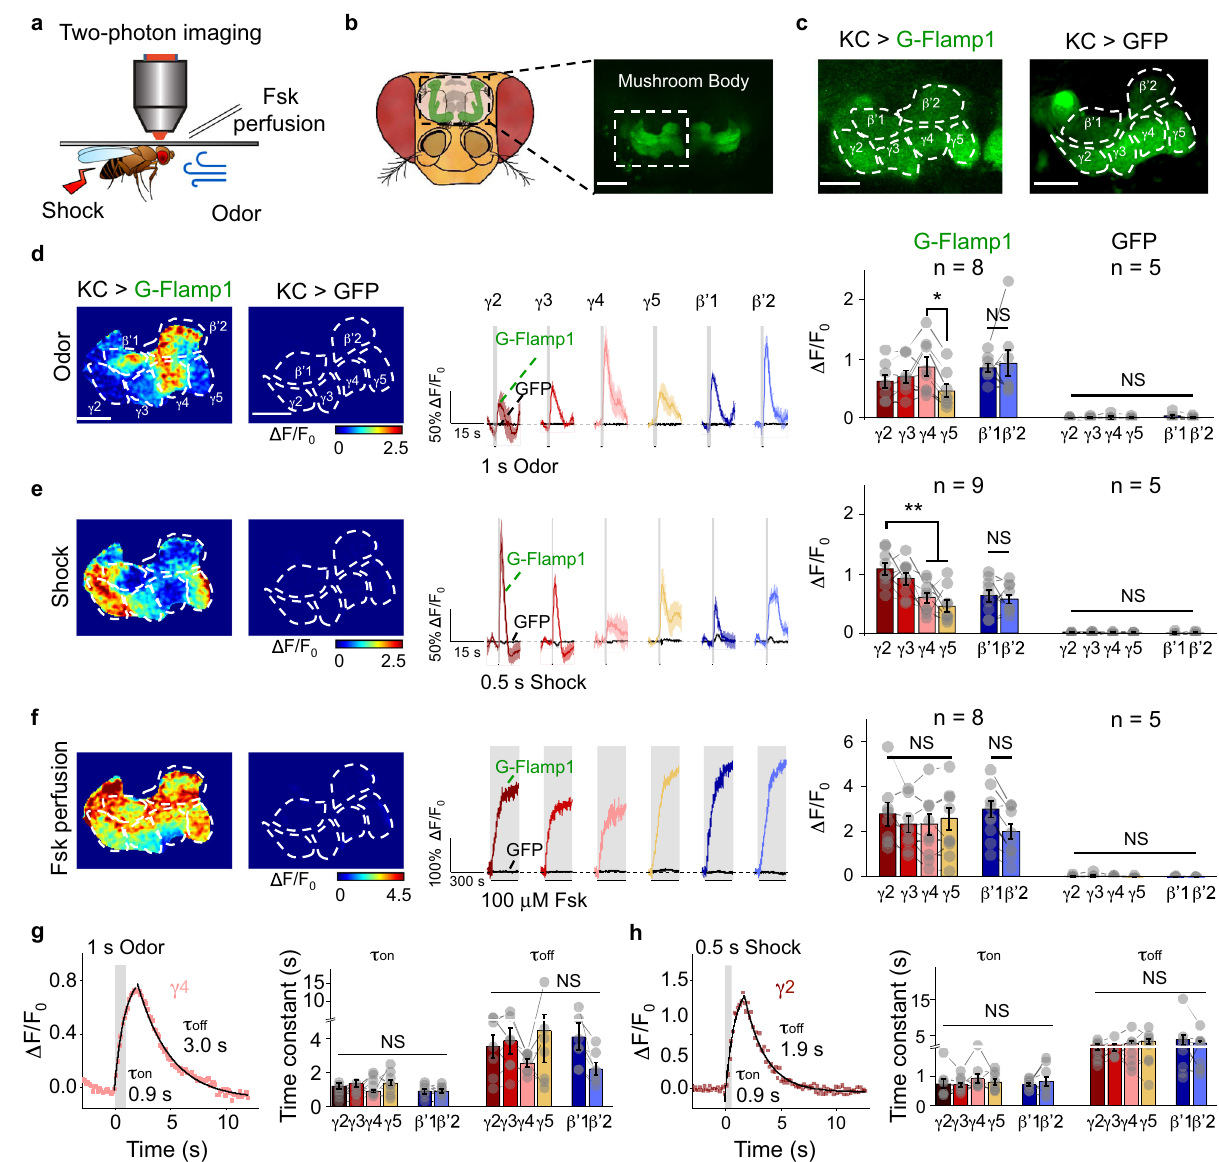
Fig. 3 | G-Flamp1 reports compartmental cAMP dynamics evoked by physio- logicalstimuliin Drosophila throughinvivotwo-photonimaging.a Schematics of in vivo two-photon imaging setup in Drosophila with multiple stimuli. b Schematics and fl uorescent images of Drosophila MB KCs. Scale bar: 50 μ m. c Representative fl uorescence images of Drosophila MB KCs expressing G-Flamp1 (left) or GFP (right) from 25 or 5 independent experiments. Scale bars: 25 μ m. d Representative pseudo-color image (left), traces (center) and quanti fi cation (right)of Δ F / F 0 to1sodor.Representative traceswere3-trialaverage fromone fl y. n =8 and 5 for G-Flamp1and GFP groups, respectively. Two-tailed Student ’ s t -tests were performed in d3. P =0.21, 0.37 and 0.048 between γ 4 and γ 2, γ 3 and γ 5, respectively.Scale bars: 25 μ m. e Similarto d exceptthat0.5selectricalshockwas appliedtothe fl y. n